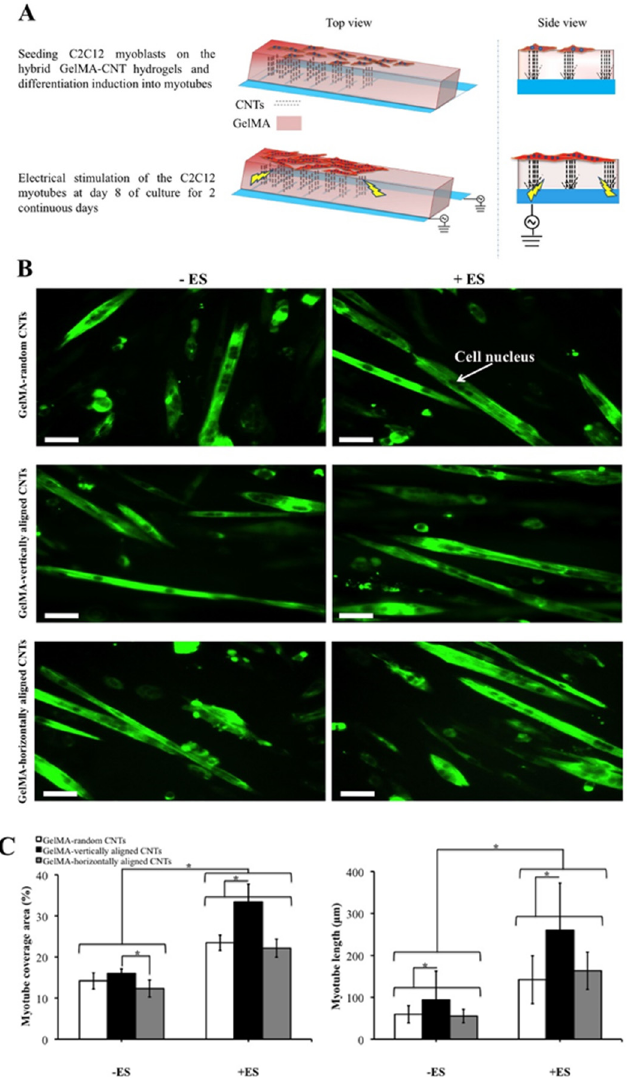
Figure 1. Di ff erentiation of C2C12 myoblasts on GelMA − 0.3 mg / mL carbon nanotube (CNT) hydrogels and characterization of the C2C12 myotubes obtained under electrical stimulation (ES). ( A ) Schematic representation of the procedure used to produce and electrically stimulate C2C12 myotubes. ( B ) Immunostaining of the fast skeletal myosin heavy chain in the C2C12 myotubes fabricated on hybrid methacrylated gelatin (GelMA)-random CNT, GelMA-vertically aligned CNT and GelMA-horizontally aligned CNT hydrogels with and without ES application (indicated as + ES and − ES, respectively) on day 10 of culture. Cell nuclei within the C2C12 myotubes were obvious after the staining procedure. The ES parameters were as follows: a voltage of 8 V, a frequency of 1 Hz and a duration of 10 ms. The scale bars represent 50 µ m. ( C ) Quantification of the myotube coverage area and myotube length of the C2C12 myotubes fabricated on hybrid GelMA-random CNT, GelMA-vertically aligned CNT and GelMA-horizontally aligned CNT hydrogels with and without ES on day 10 of culture. Data in part ( C ) are presented as mean ± standard deviation obtained from at least 40 myotubes of 2 independent experiments. Asterisks indicate significant di ff erences between samples (* p < 0.05). Reproduced from [50].